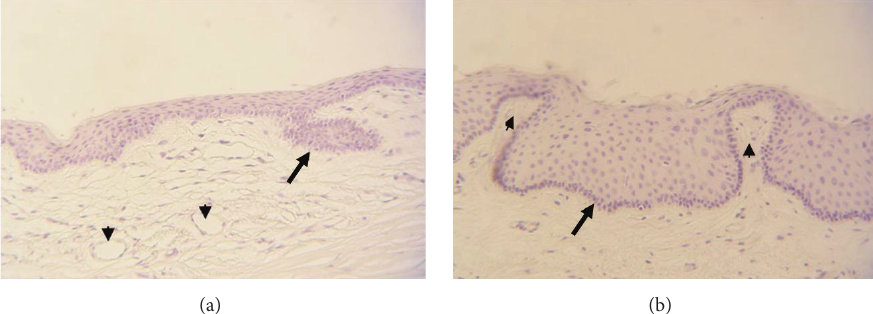
Figure 2: Haematoxylin staining of cross section through normal limbal region. Arrow in (a) indicates a LESC containing limbal epithelial crypt; arrowheads indicate blood vessels. Arrow in (b) indicates a limbal crypt, flanked by two focal stromal projections